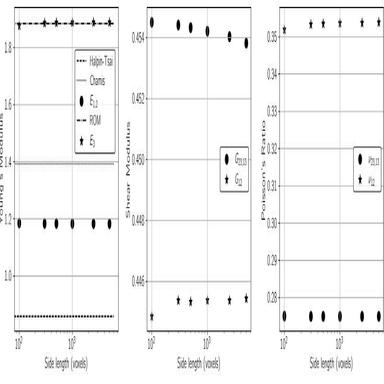
Mechanical properties for the square array of cylinders with different resolutions.